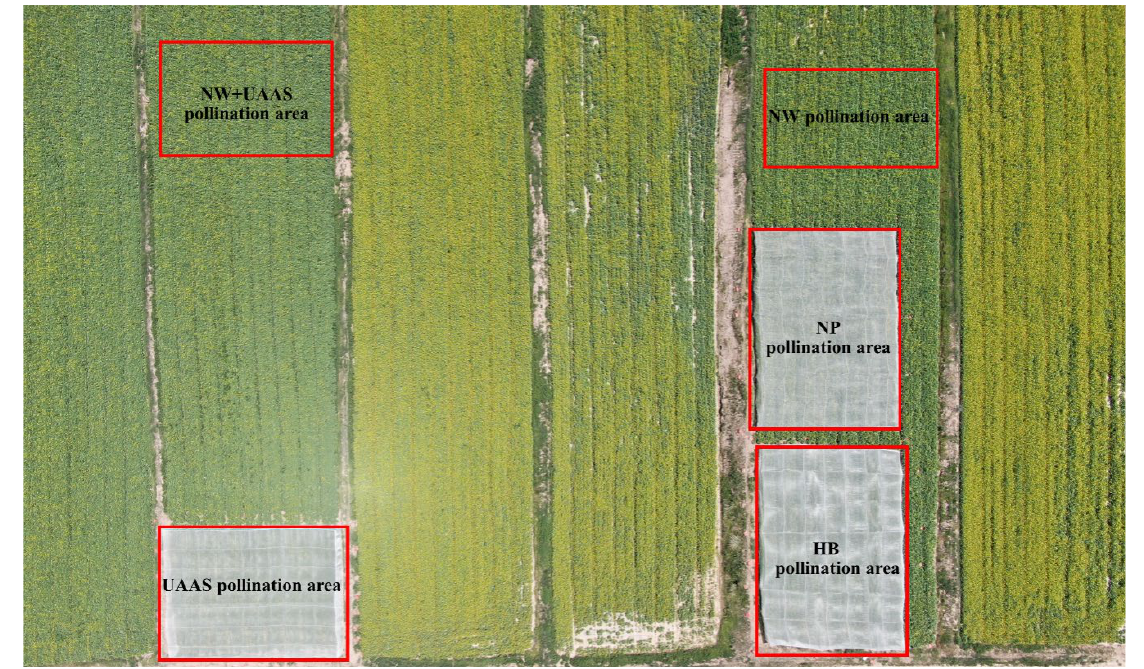
Figure 2. The whole experimental field and each pollination area setting (top view).